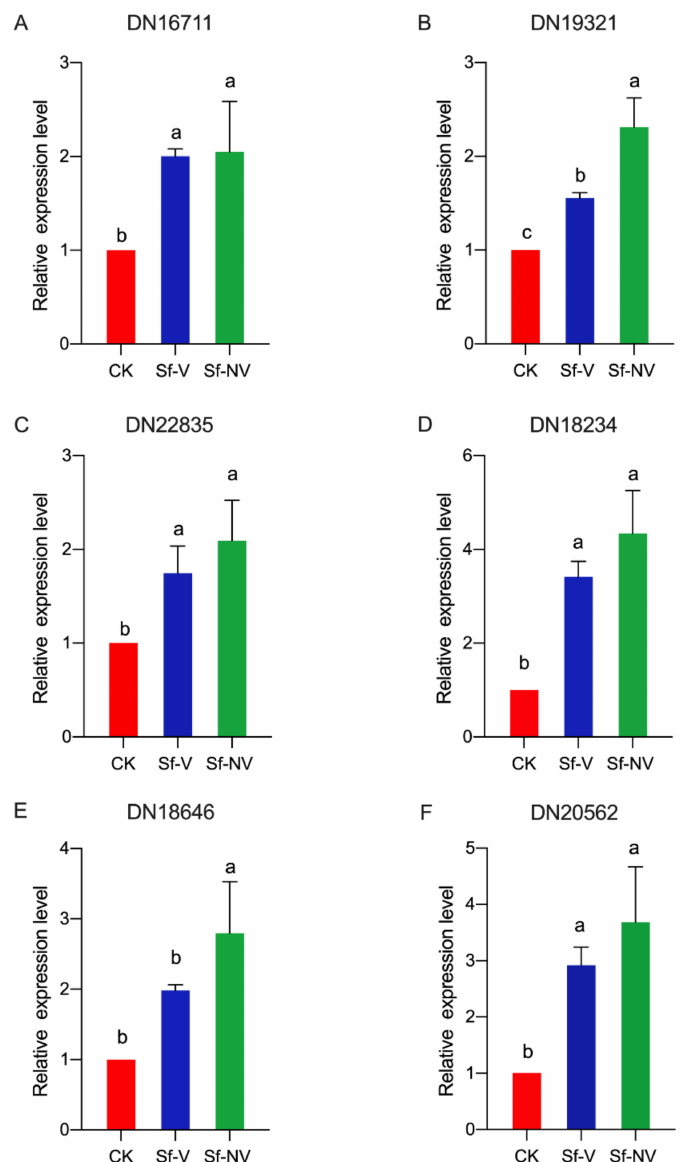
Figure 6. The expression levels of female-specific genes in S. furcifera acquired SRBSDV or not: Sf–V, S. furcifera females acquired SRBSDV; Sf–NV, S. furcifera females failed to acquire SRBSDV; CK, S. furcifera females exposed to healthy rice plants. Expression was normalized to the level of SfEF1 α that serves as the internal standard. The relative mRNA levels of female-specific genes in CK were arbitrarily set to 1. Different letters over the bars (mean ± S.E.) indicate significant differences (Tukey test, p <